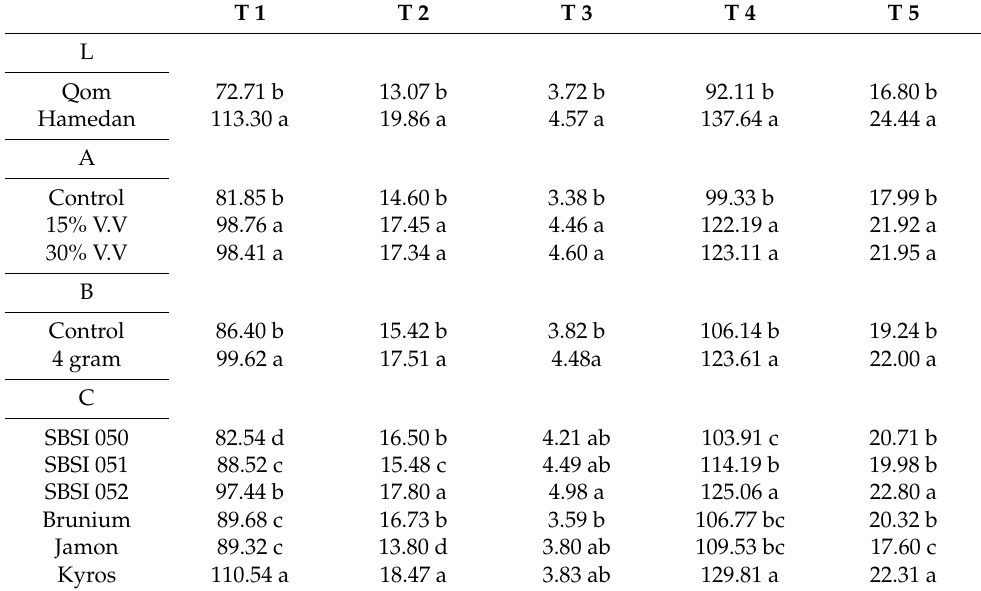
Table 3. Mean comparison of evaluated quantitative traits. T 1: Root yield (t/ha); T 2: Root dry matter yield (t/ha); T 3: Shoot dry matter yield (t/ha); T 4: Total yield (t/ha); T 5: Total dry matter yield (t/ha); A: Methanol concentration; B: Glycine betaine concentration; C: Genotypes; L: Location; Means followed by the same letter(s) is/are not significantly differ at 5% level of